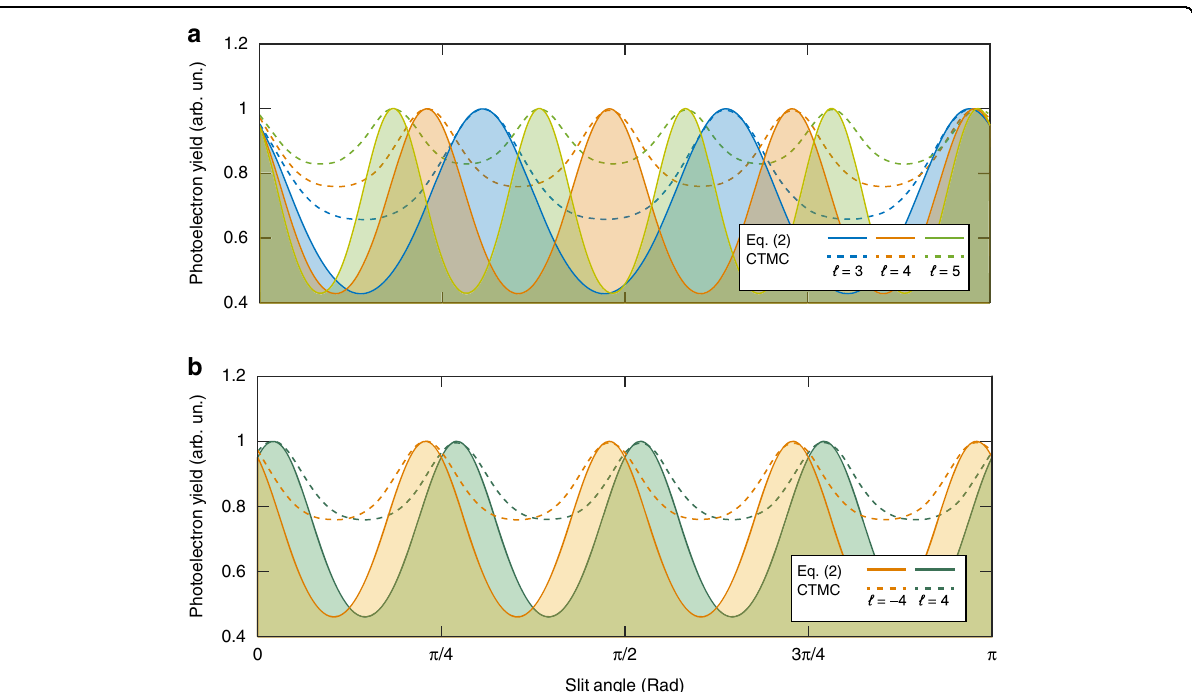
Fig. 5 Universal scheme for detecting light OAM by employing strong- fi eld ionization measurement. We inspect the yields of photoelectrons, whose emitting angles ξ are con fi ned in a range ( ξ ϵ [0, π /6]), with respect to the slit angle. Different topological charges of probing light fi elds ( ℓ = 3, ±4, and 5) can be clearly revealed according to the peak number and position of the photoelectron yields. The solid lines illustrate the results of our analytical model and the dashed lines show the calculations by using the CTMC model. a The results for OAM modes of different magnitudes ( ℓ = 3, 4, and 5). b The results for OAM modes of opposite signs ( ℓ =